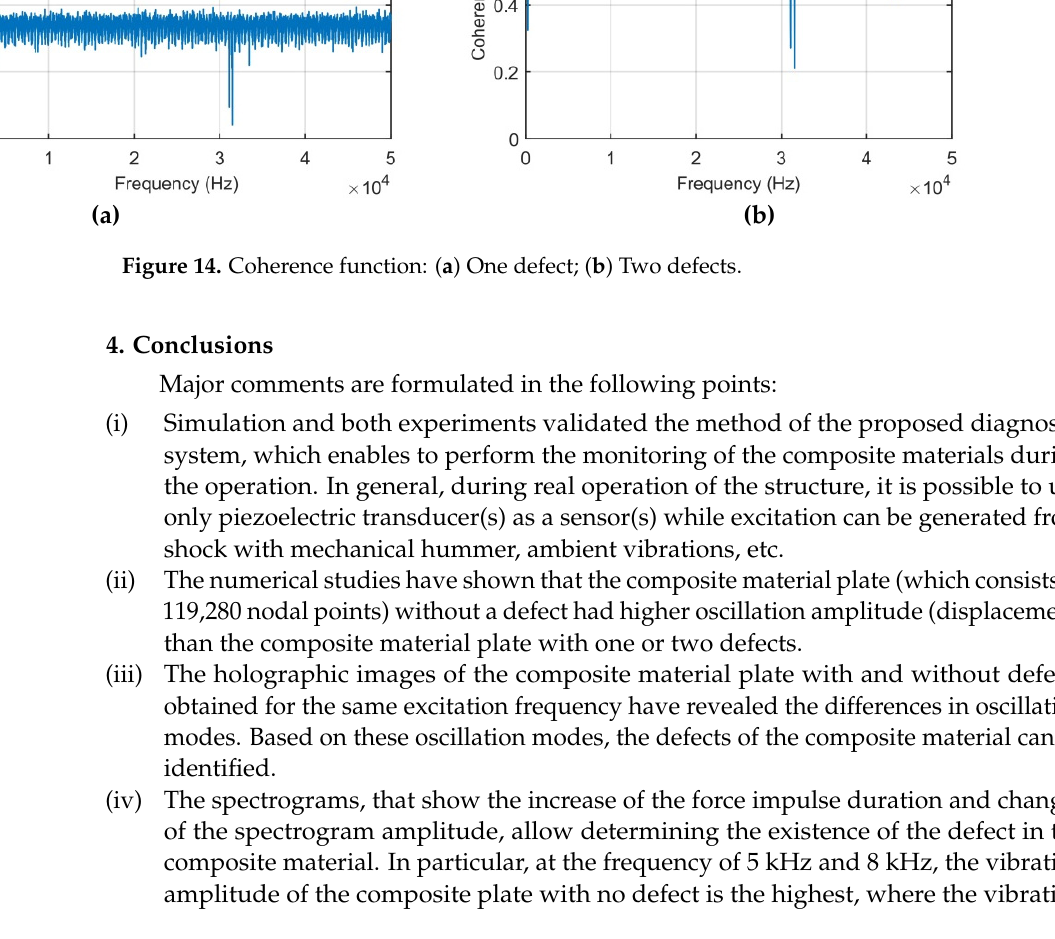
Figure 13. Damage index values: ( a ) One defect; ( b ) Two defects.